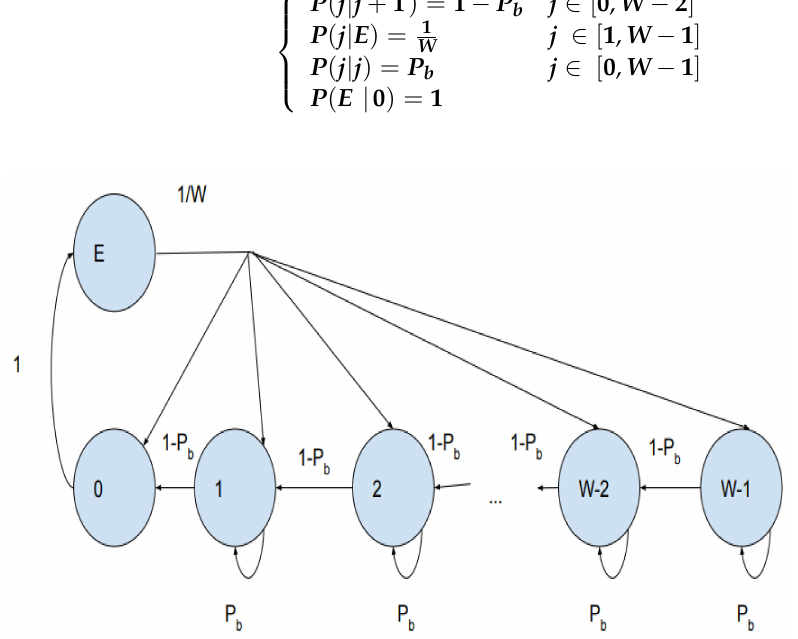
Figure 8. Markov chain model for broadcasting safety messages in